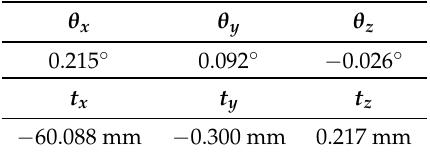
Table 3. Calibrated extrinsic parameters from Cam0 to